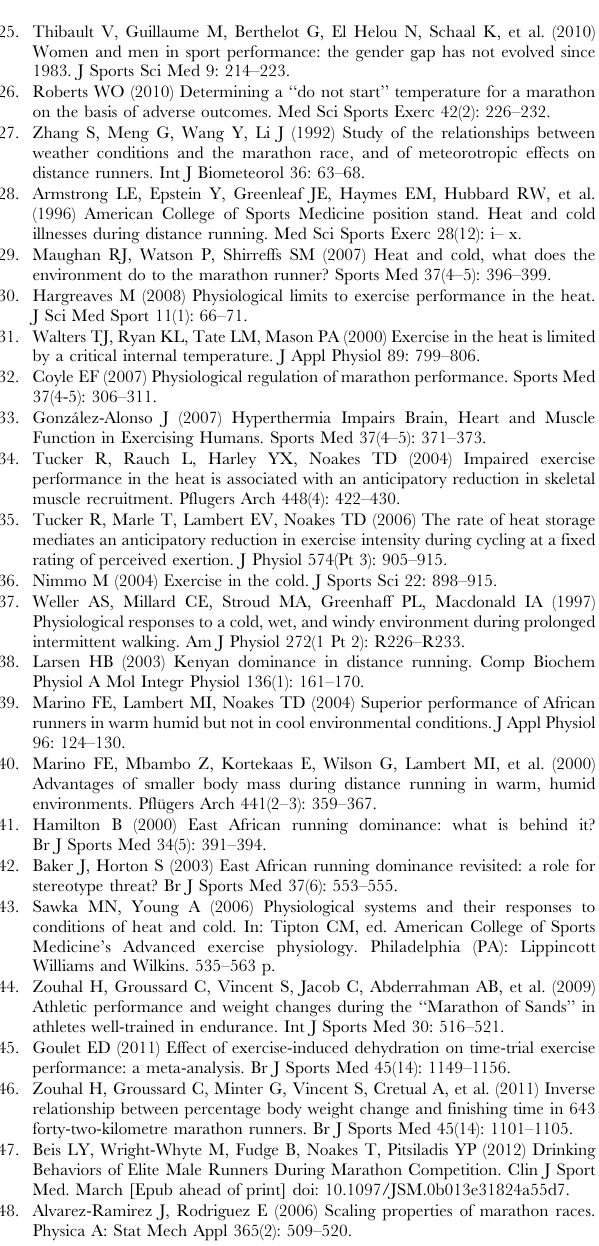
Table S2 Spearman correlations results between each marathon performance levels and environmental pa-